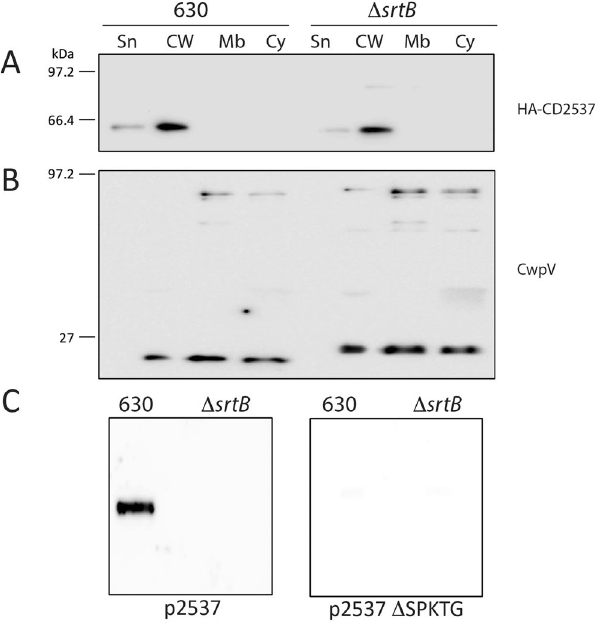
Figure 4. Sortase covalently anchors CD2537 to the peptidoglycan. Cells of wild type 630 and the Δ srtB mutant expressing plasmid-encoded CD2537 HA -CwpV fusion protein were fractionated into supernatant (Sp), cell wall (CW), membrane (Mb) and cytoplasm (Cy) compartments. Protein fractions were analysed by western blot using anti-HA antibody ( A ) or anti-CwpV Type II repeats antibody ( B ). Peptidoglycan fractions were purified from wild type 630 and the Δ srtB mutant expressing full length CD2537 HA or its Δ SPKTG derivative and analysed by dot blot with anti-HA tag antibodies to detect the presence of CD2537 covalently anchored to peptidoglycan ( C ). Western blots were cropped for clarity; uncropped images can be found in Supplementary Fig.